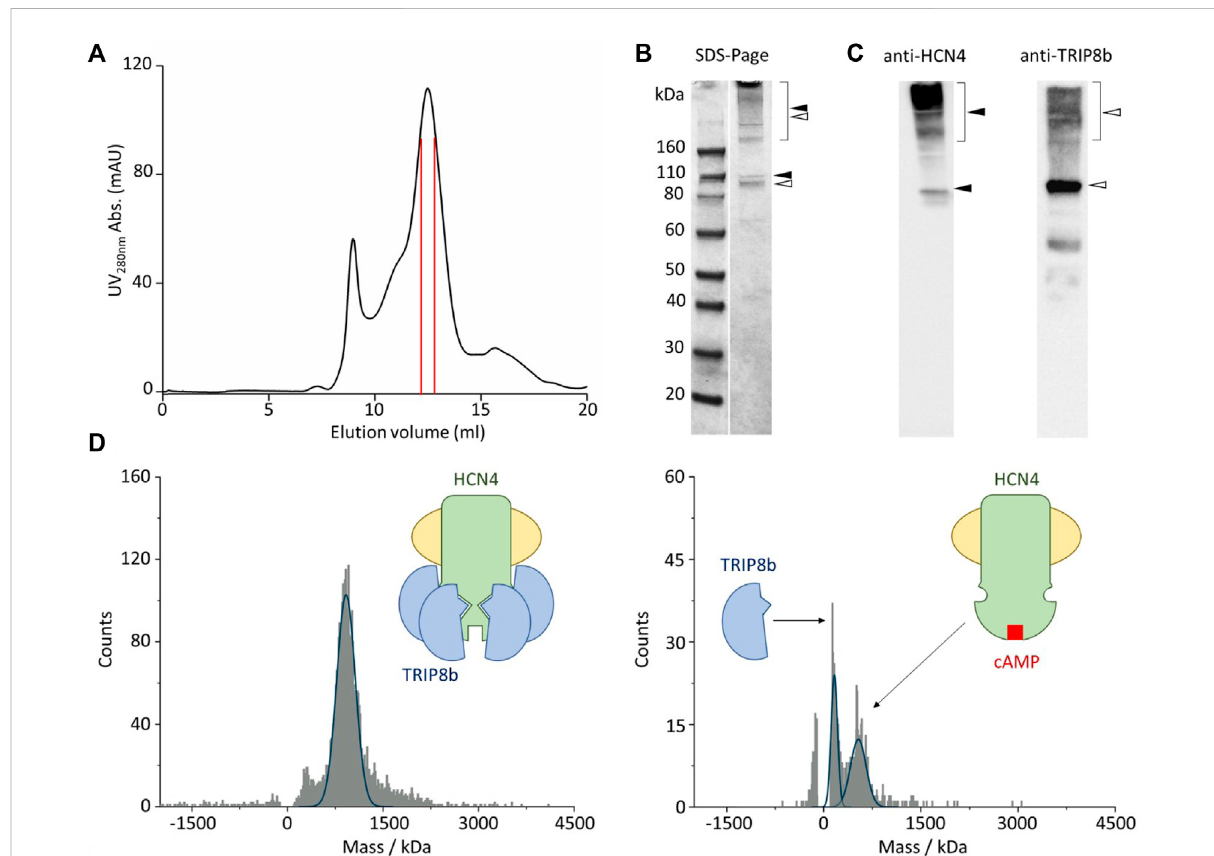
FIGURE 2 Single molecule mass photometry of HCN4 — EGFP-TRIP8b complex. (A) SEC of HCN4 — EGFP-TRIP8b complex following puri fi cation in LMNG/CHS. Peak fractions used for MP are delimited by the red lines. (B) SDS-PAGE gel of the pooled SEC fractions of HCN4 — EGFP-TRIP8b complex, stained with Coomassie blue. Filled arrows indicate HCN4, while open arrows indicate EGFP-TRIP8b, in their oligomeric (square bracket), and monomeric forms. (C) Western blots of the pooled SEC fractions of HCN4 — EGFP-TRIP8b complex performed by using anti-TRIP8b and anti-HCN4 antibodies, respectively. Open and fi lled arrows as in panel (B) . Of note that the western blot anti-TRIP8b reveals the presence of a small number of molecules (faint band between 60 and 50 kDa markers) corresponding N terminally degraded TRIP8b. Indeed, they co-puri fi ed with HCN4 and thus have retained the HCN binding sites located in their C-terminal half (Santoro et al., 2004; Santoro et al., 2011). (D) Mass histogram of binding events for HCN4 — EGFP-TRIP8b complex before (left) and after the addition of 2 mM cAMP (right). The blue lines represent the fi tting of the data with Gaussian Distribution Function. Left, schematic representation of puri fi ed HCN4 (green) embedded into a detergent micelle (yellow) and bound to four TRIP8b molecules (blue). Right, puri fi ed HCN4 bound to cAMP (red) has lost